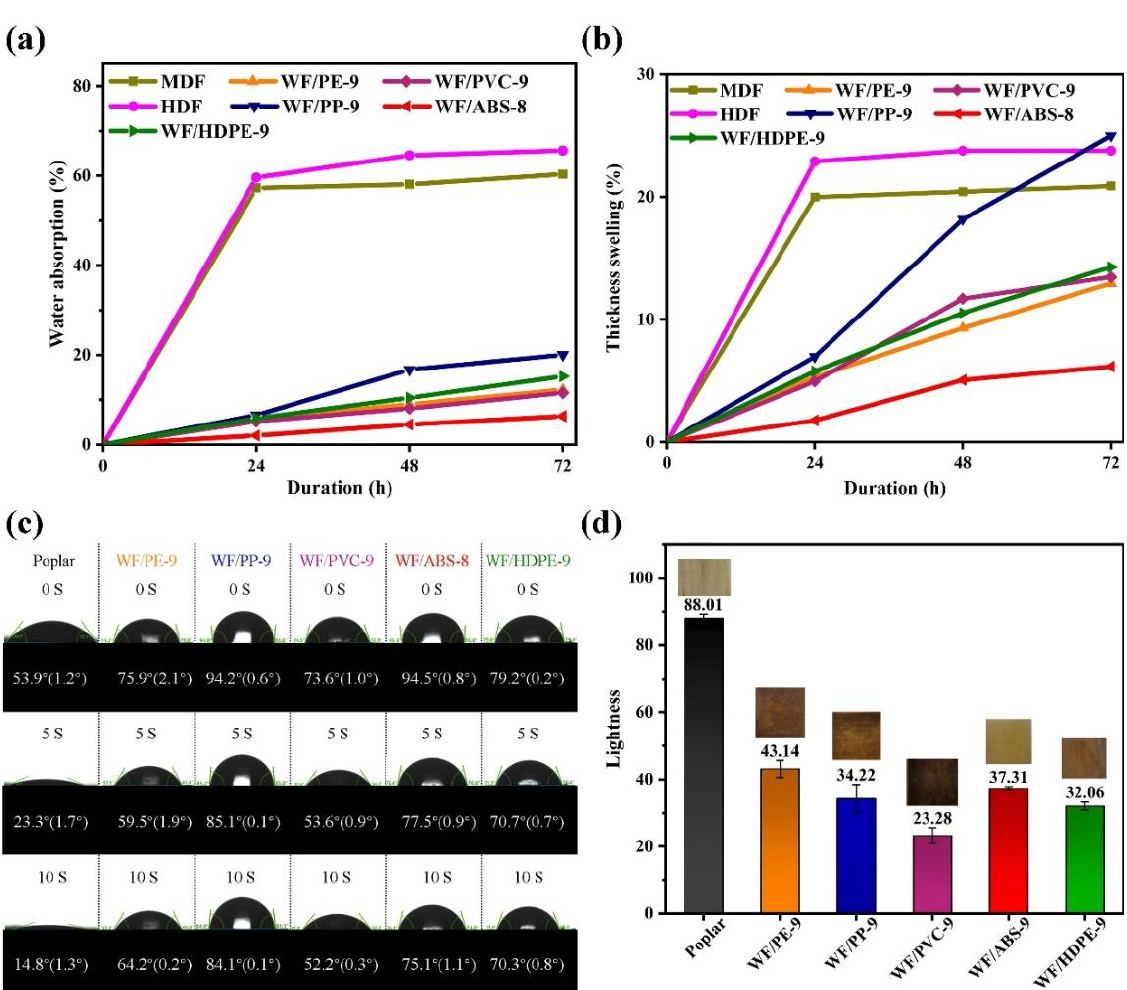
Figure 5. ( a ) Water absorption of WPC, MDF and HDF. ( b ) Thickness swelling of WPC, MDF and HDF. ( c ) Contact angle of WPC and poplar at 0 s, 5 s and 10 s. ( d ) Lightness contrast of WPC and